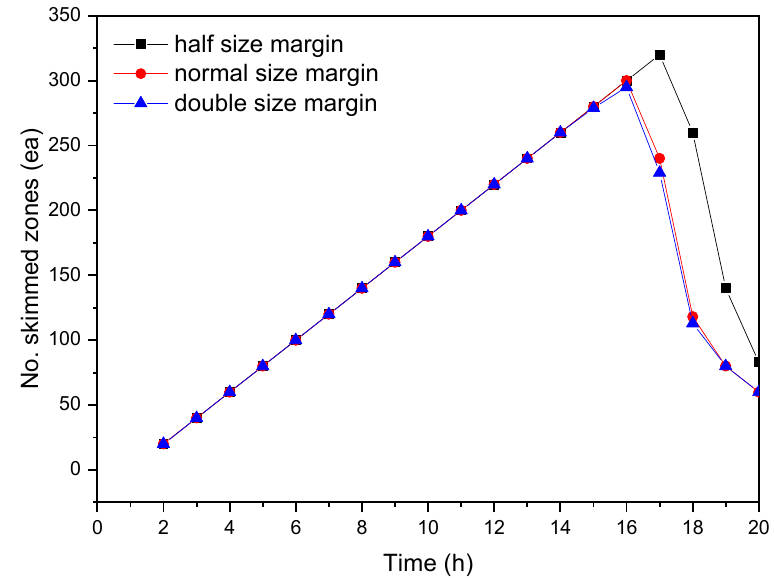
Figure 14. E ff ect of marginal length on the number of skimmed zones (uncertainty of SNR model for 500 kl spill case